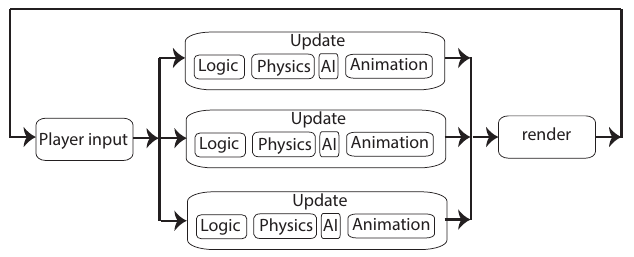
Figure 4. Data Parallel Model.